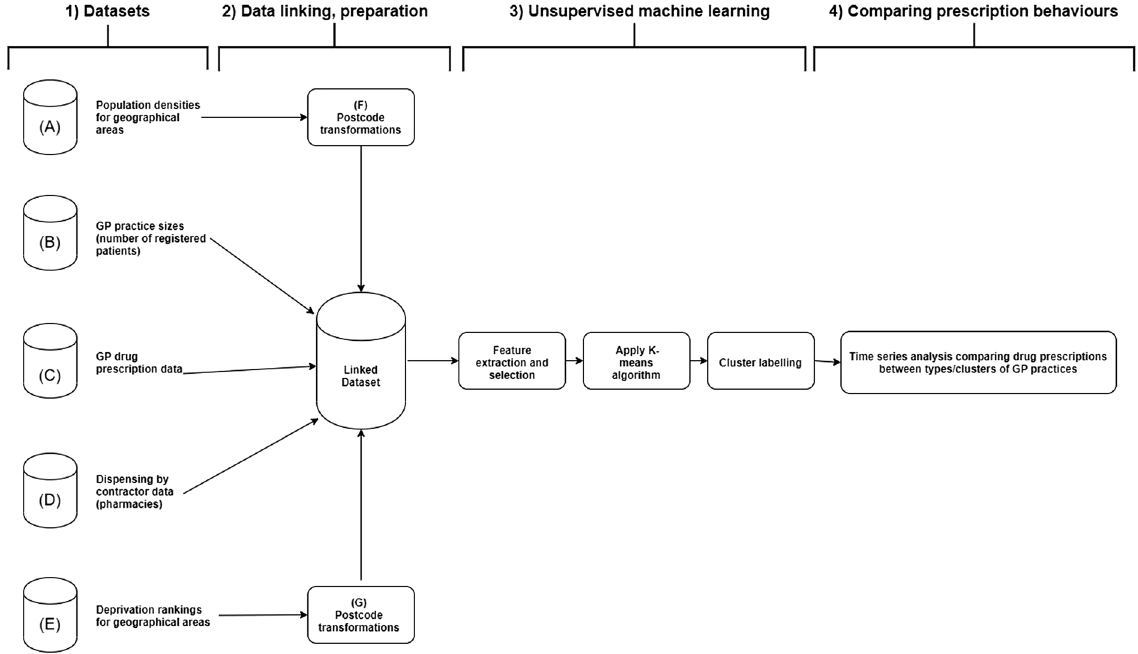
Figure 1. Workflow used for investigating prescription behaviours of General Practitioner practices based on Geolocation using Time Series Analysis and K-means Clustering.